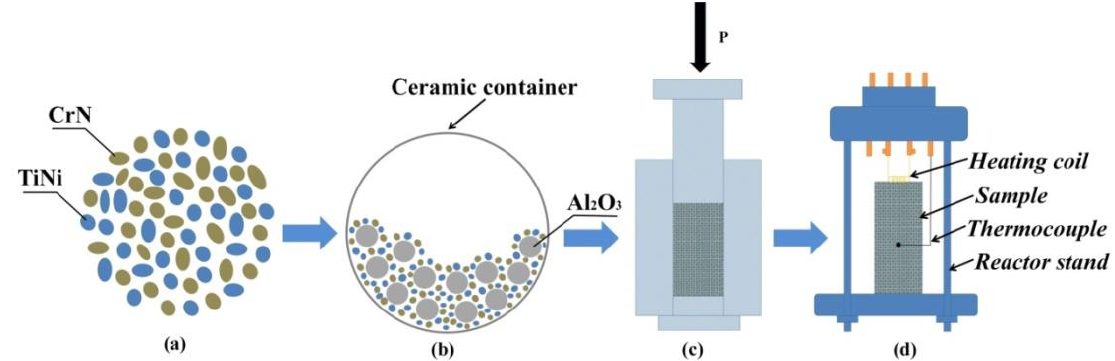
Figure 1. Initial scheme for the preparation of samples: ( a ) the components of the initial powder mixture, ( b ) mixing components in a ball mill, ( c ) pressing of samples from powder mixture 54.6 wt.% CrN + 45.4 wt.% TiNi, ( d ) the reactor stand with a sample obtained from a powder mixture.